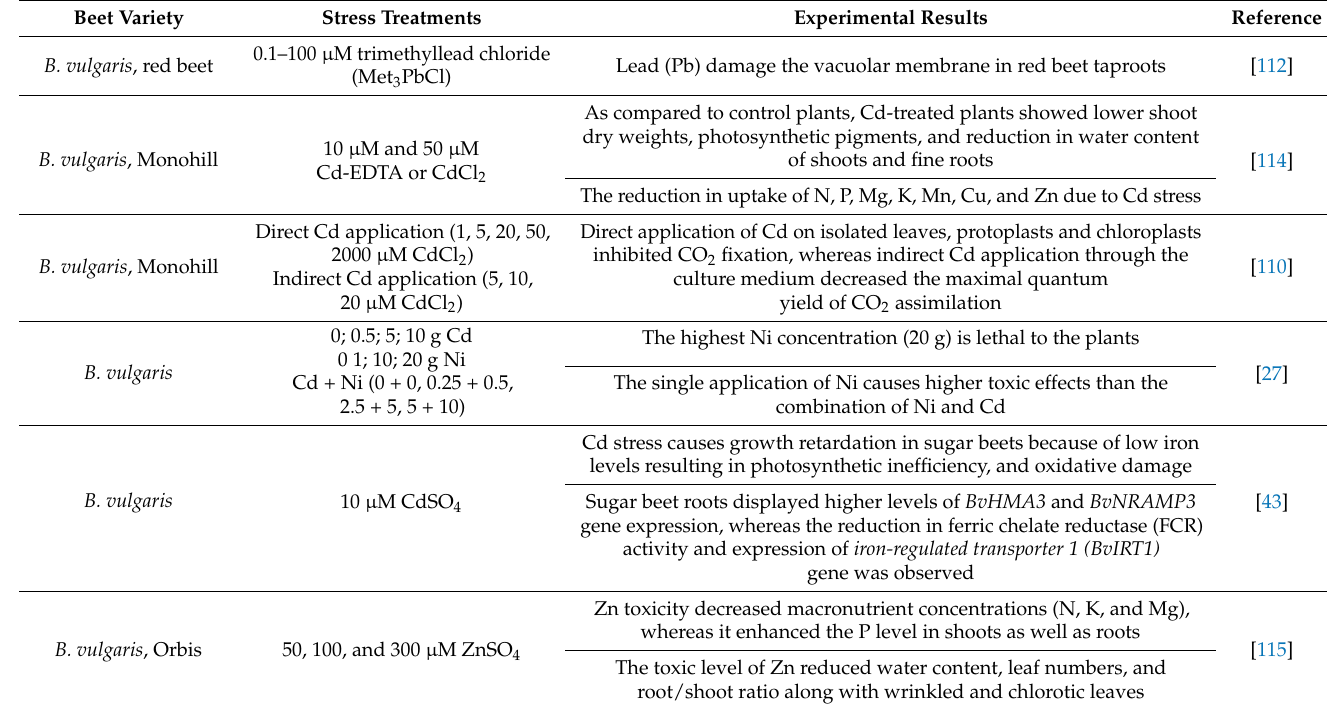
Table 4. Heavy metal stress responses in